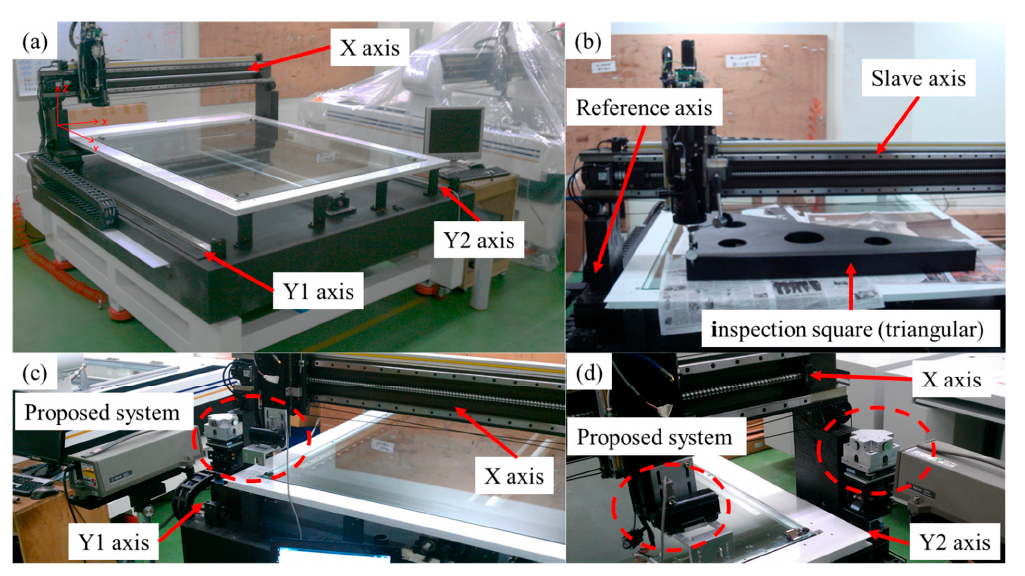
Figure 23. Case 4 parallelism error measurement setup. Table 9. The parallelism error measurement results. Parallelism Angle Error